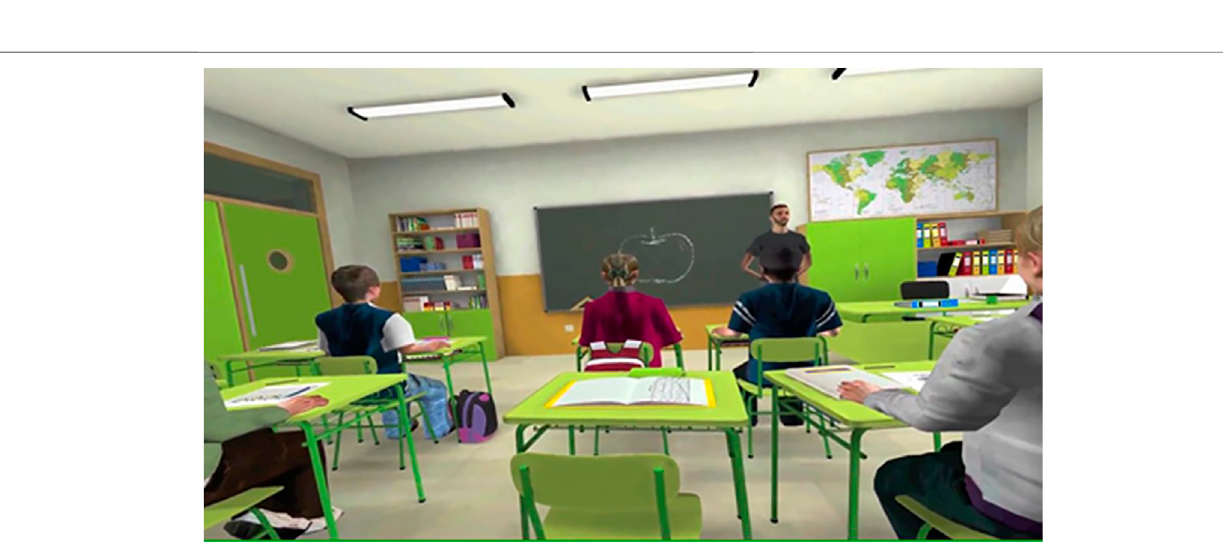
Frontiers in Virtual Reality |